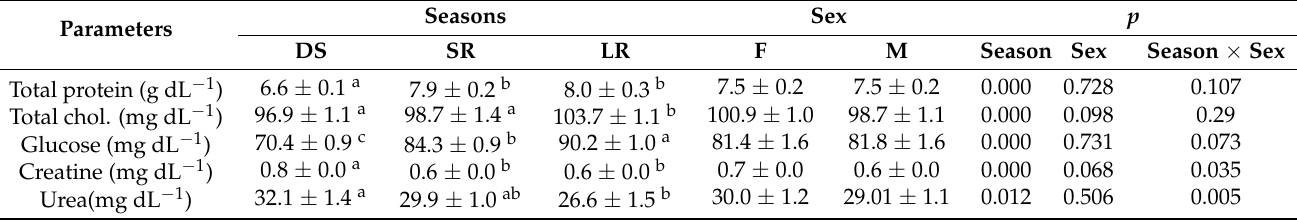
a–c Rows with different superscripts for same parameter are significantly different, DS = dry season, SR = short rainy season, LR = long rainy season, F = female, M= male, Total chol. = total cholesterol, gdL − 1 = gram per deciliter, mg dL − 1 = milligram per